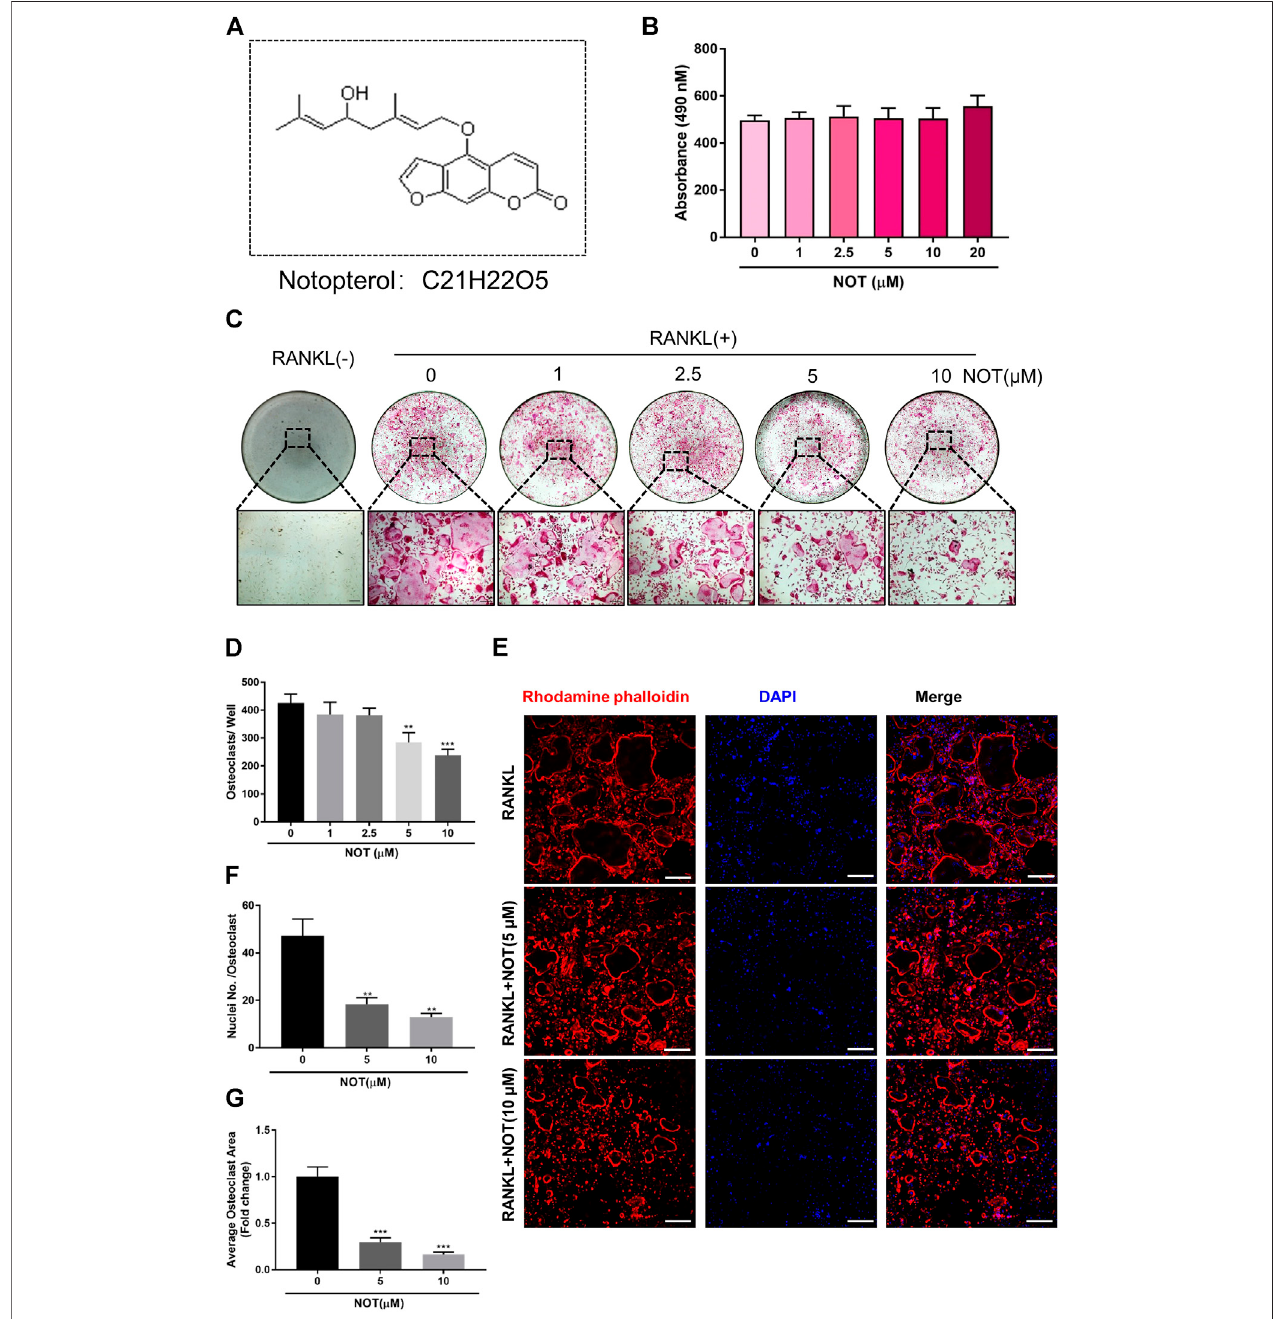
FIGURE1| Notopterol inhibitsRANKL-inducedosteoclastogenesis invitro . (A) Chemicalstructure ofNotopterol. (B) Effect ofindicatedconcentrationsNotopterol on viability of BMMs as measured by MTS assay. (C) Representative light microscope images of RANKL-induced osteoclast formation treated with indicated concentrations of Notopterol for 5 days (Scale bar (cid:2) 200 μ m). (D) Quanti fi cation of TRAcP-positive multinucleated cells (nuclei > 3) treated with indicated concentrations of Notopterol. (E) Representative confocal images ofmature osteoclasts stained for F-actin belts and nuclei (Scale bar (cid:2) 200 μ m). (F) Quanti fi cation ofthe average number of nuclei involved in TRAcP-positive multinucleated cells. (G) Quanti fi cation of the area of F-actin belts occupied by osteoclasts per fi eld. “ − ” means RANKL untreated; “ + ” meansRANKLtreated.Dataarepresented asmean ± SEM.All invitro experimentswererepeatedthreetimeswithsimilarresults.** p < 0.01,*** p < 0.001 relative to RANKL-induced